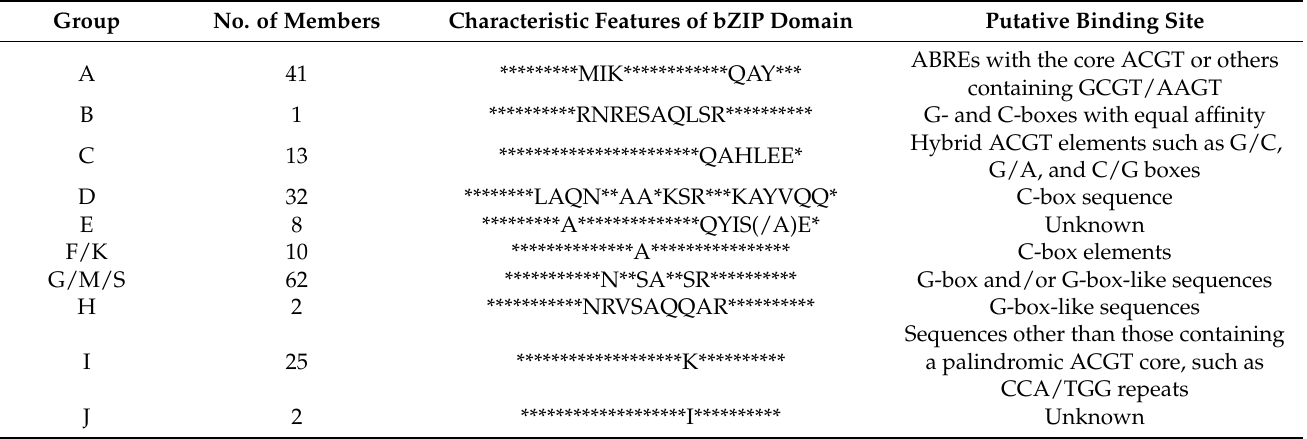
Table 1. Predicted DNA binding site of GhbZIP transcription factors.